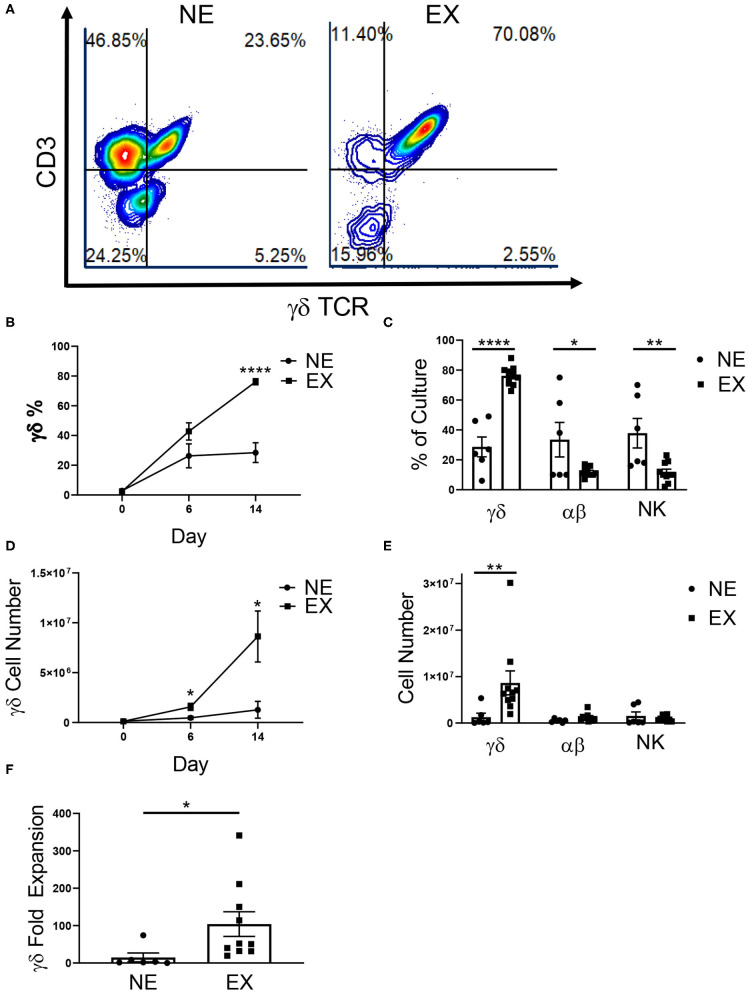
Expansion of healthy donor γδ T cells. γδ T cells were expanded from healthy donors, labeled either Non-Expanders (NE, n = 6) or Expanders (EX, n = 10) in two independent experiments. (A) Representative flow cytometry plots showing the percentage of γδ T cells (CD3+ γδTCR+), αβ T cells (CD3+ γδTCR–), and NK cells (CD3– γδTCR–CD56+) in culture on day 14 of expansion. (B) The percentage of γδ T cells was significantly higher for EX by day 14 of expansion (Student's t-test, p < 0.000001). (C) On day 14, EX had a greater percentage of γδ T cells in culture (p < 0.0001), while NE had a greater percentage of αβ T cells (p = 0.022) and NK cells (p = 0.003) (two-way ANOVA). (D) Compared to NEs, EXs had a larger number of γδ T cells in culture on day 6 (Student's t-test, p = 0.037) and 14 (Student's t-test, p = 0.048) of expansion. (E) EX had a greater number of γδ T cells compared to NE (p = 0.002), however there were no differences between EX and NE for the number of αβ T cells or NK cells in culture (two-way ANOVA). (F) Due to greater cell growth, EX also had a greater fold expansion of γδ T cells (Student's t-test, p = 0.031). *p < 0.05; **p < 0.005; ****p < 0.00005.